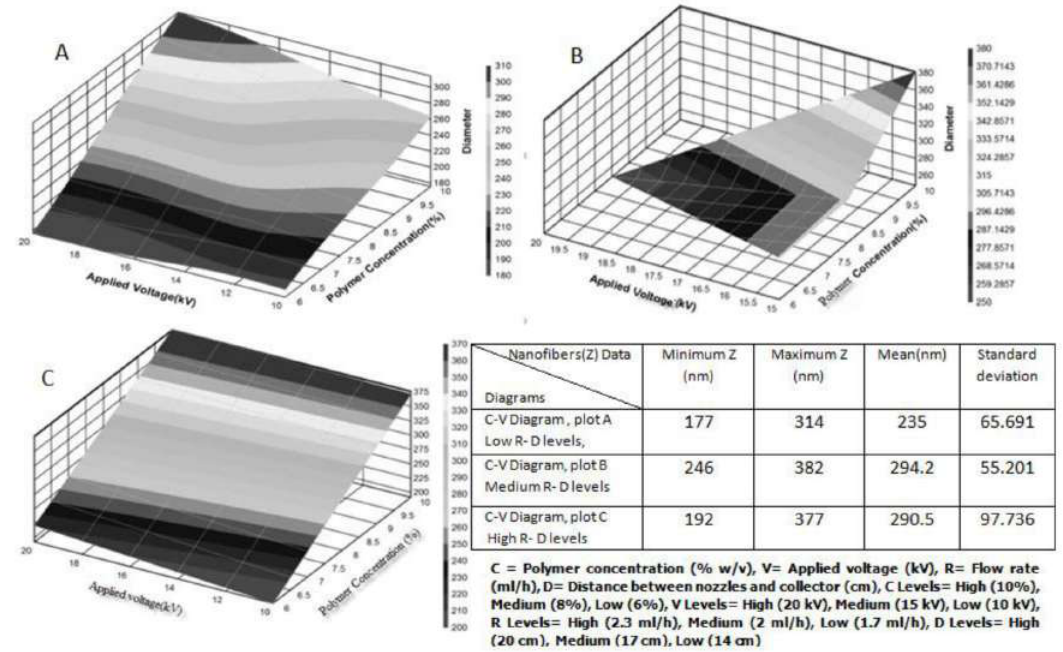
Fig. 3. The data and 3 D plots of nanofibers diameter predicted by ANN fixed in mentioned levels (C-V diagrams)